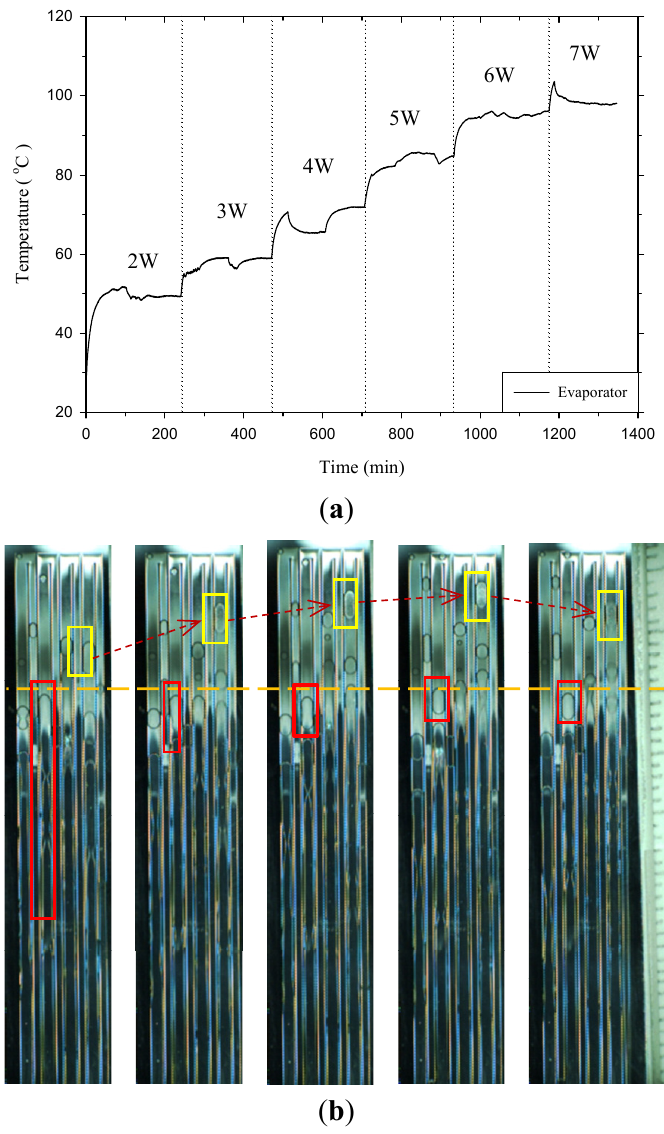
Figure 5. ( a ) Time vs. junction temperature variation of the evaporator. ( b ) Fluid flow at different time instants measured in increments of 0.05 s of a vertically oriented μ PHP having nonuniform channels and an input power of 4